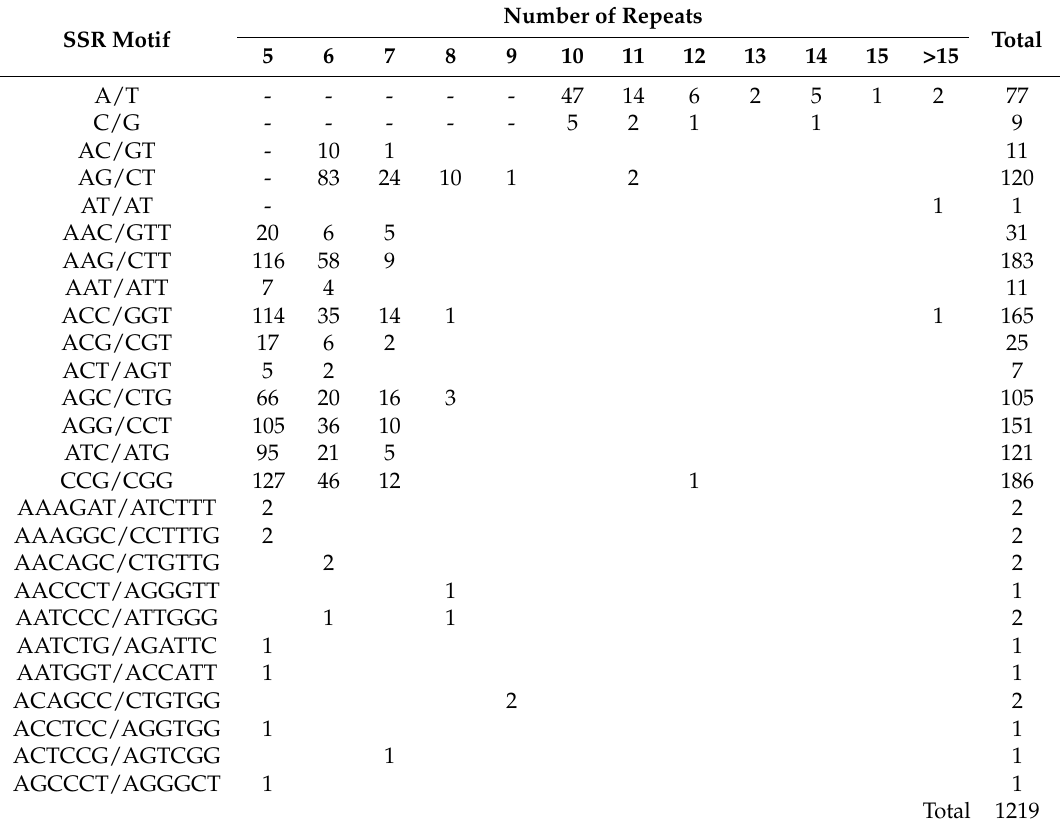
Table 2. The number of non-redundant SSRs in a set of 1219 patchouli expressed sequence tags